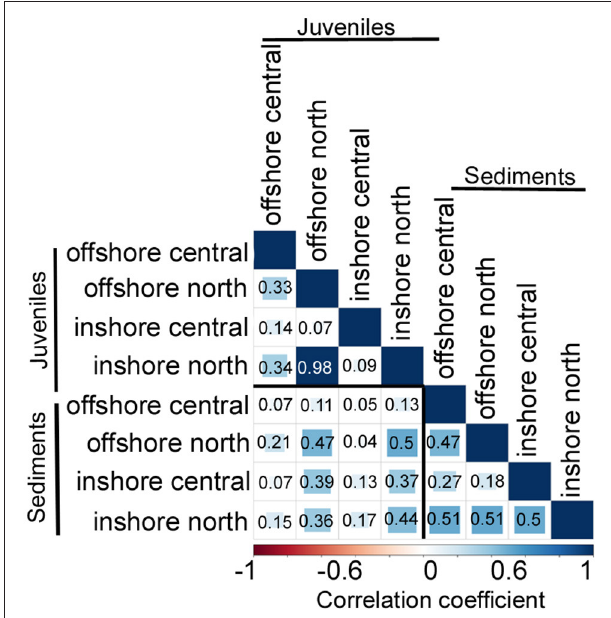
FIGURE 3 | Matrix of pairwise correlation coefficients between Symbiodinium communities associated with juveniles vs. in the sediments across latitudes (northern vs. central GBR) and water quality gradients (inshore vs. offshore). The scale bar represents coefficients from − 1 in red (100% negatively correlated) to 1 in dark blue (100% positively